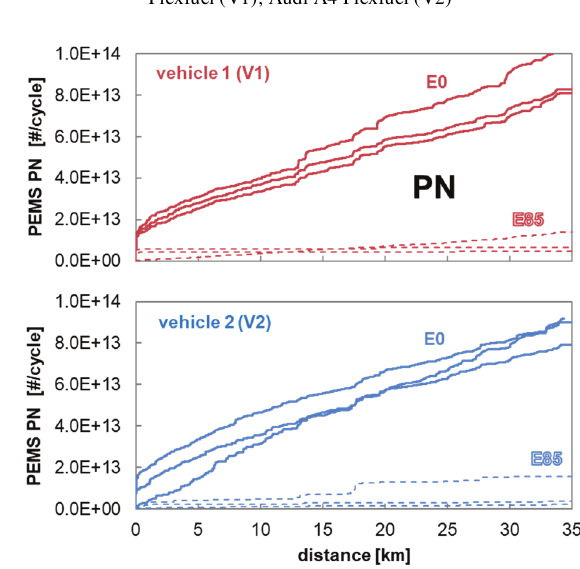
Fig. 7. CO 2 – Emissions during RDE with E0 and E85; Volvo (V1); Audi (V2)